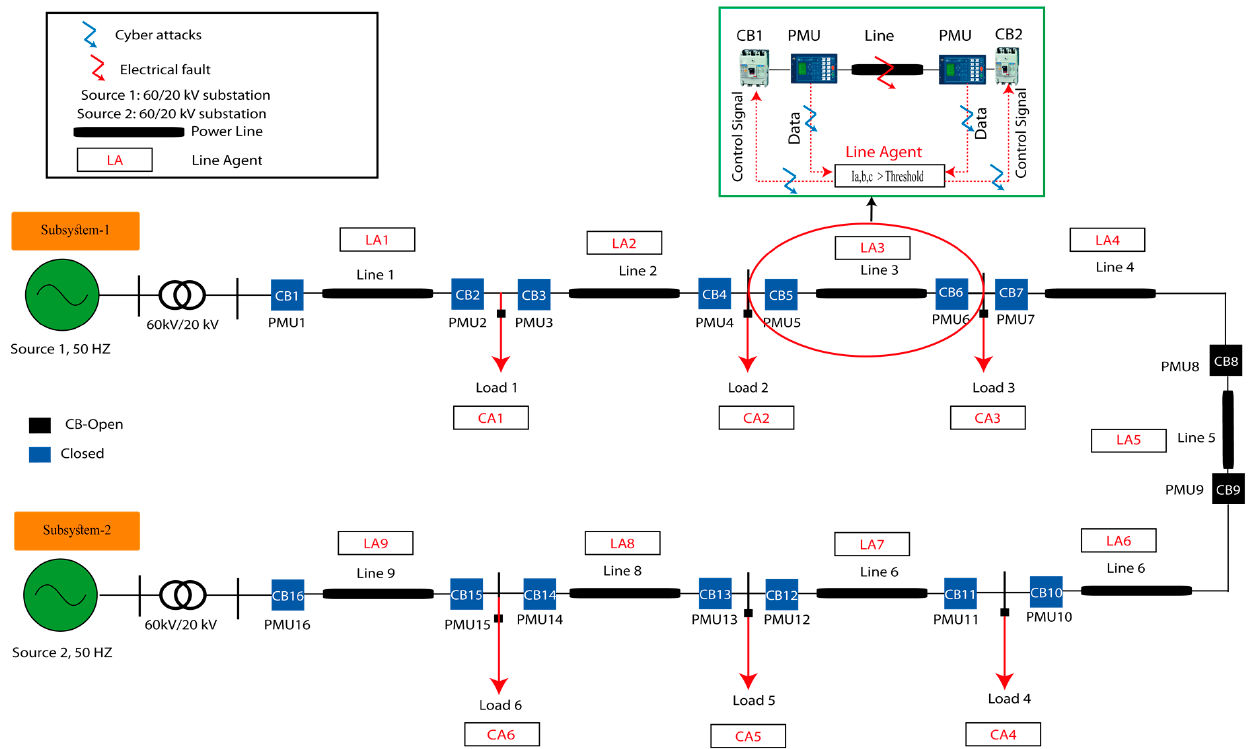
Figure 5. Diagram of the radial test system with multi-agent cyber-attack detection. Table 1. Test power system